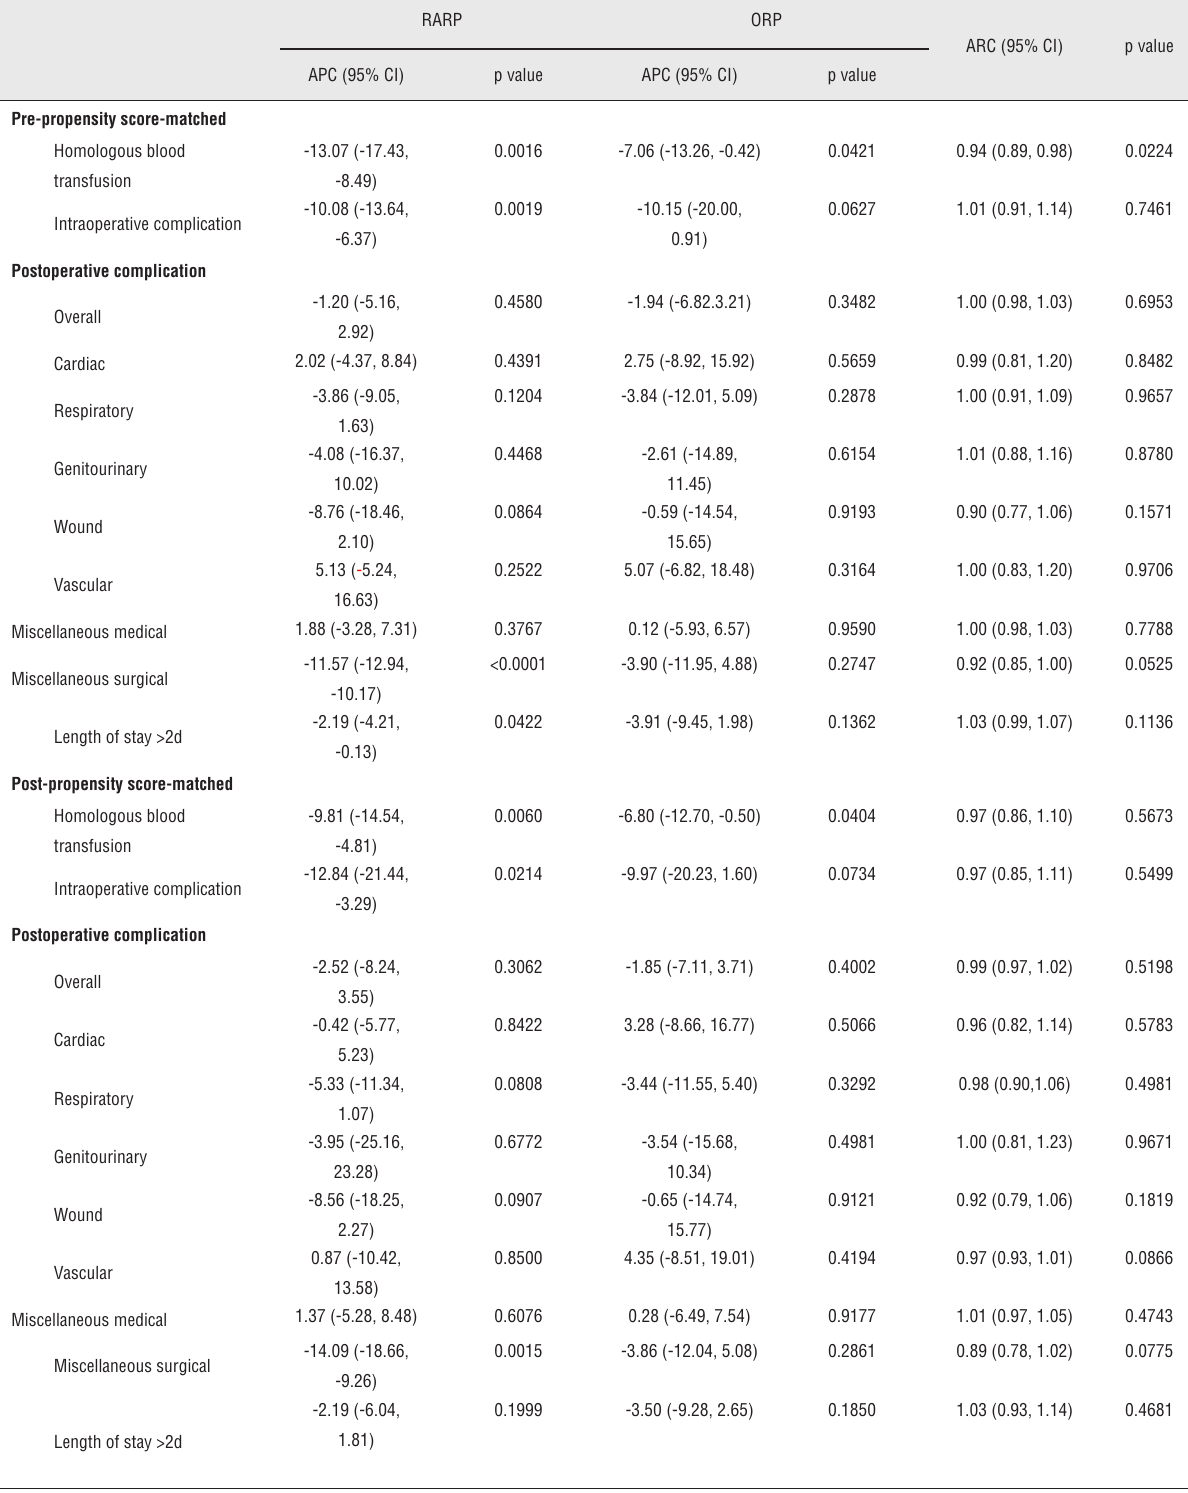
ARC (95% CI) p value